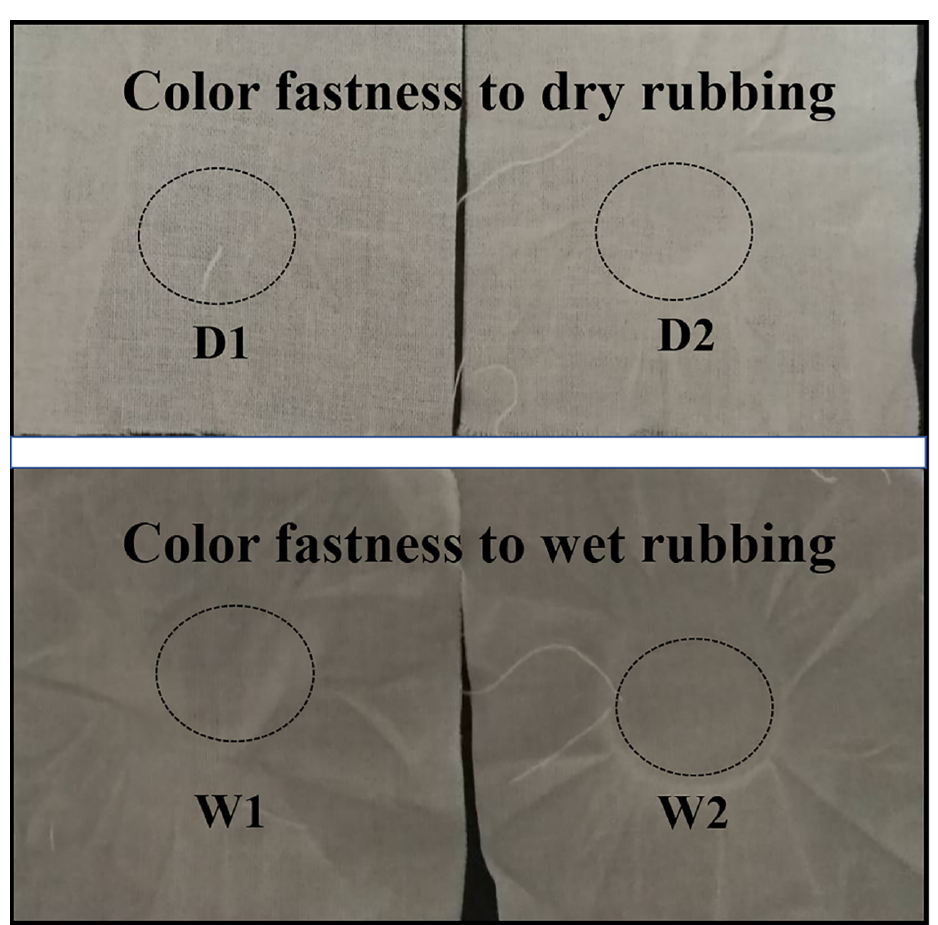
Figure 7. Comparison of the dry and wet color fastness of pristine and PDMS/STA/SiO 2 -coated fabrics.